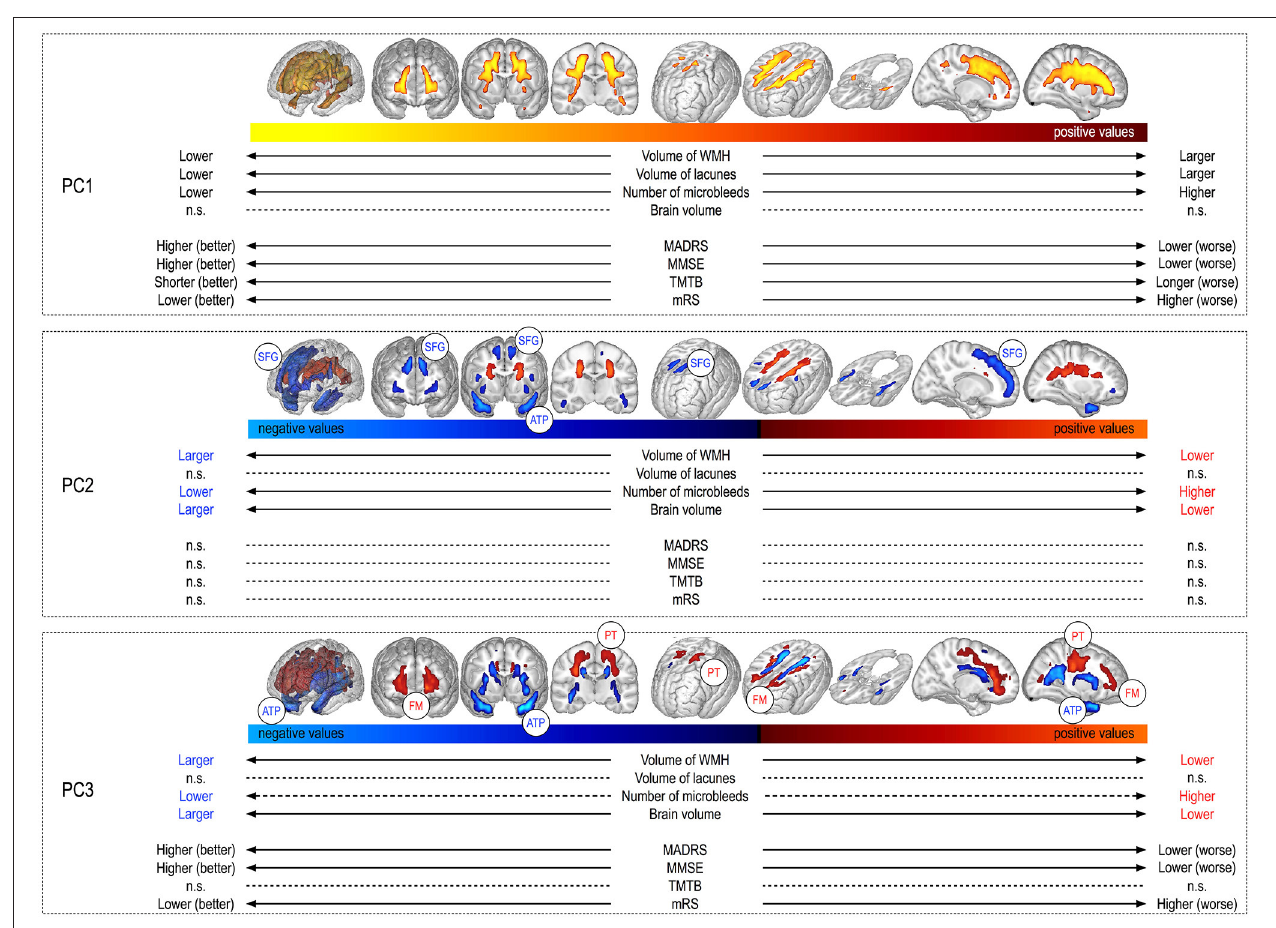
FIGURE 2 | Visual aspect of principal components and their relationships with other MRI markers and clinical scores. Each box depicts one principal component. The Top of the box shows the component pattern (the combination of voxels that explains a part of the variability of WMH shape) and the Bottom the corresponding component value. The component value describes the position of a given patient with respect to all the others for a given component pattern. For instance, PC1 represents the volume of WMH, and as such, patients with large extents of WMH will have large PC1 values and lie on the right of the colour shade, while those with low extents will lie on the left of the colour shade. The links between the component values and the different MRI markers and clinical scores are also represented. For instance patients with large extents of PC1, having large volumes of WMH, also have larger volumes of lacunes. MDRS, mattis dementia rating scale; MMSE, mini mental state examination; TMTB, trail making test version B; mRS, modified Rankin’s Scale; BPF, parenchymal brain fraction; LL V , volume of lacunes; WMH V , volume of white matter hyperintensities; MB N , number of microbleeds; SFG, superior frontal gyrus; ATP, anterior temporal pole; PT, pyramidal tract; n.s., absence of significant relationship between considered variables.